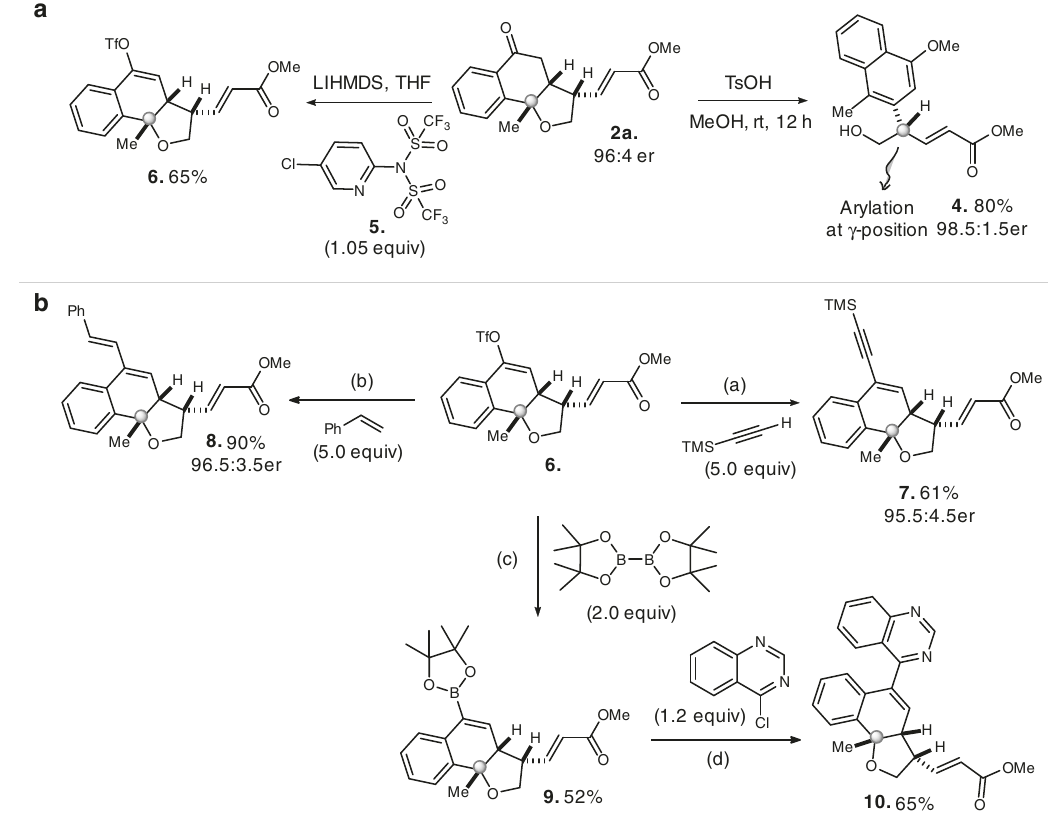
Fig. 7 Transformations of resolution products. Conditions: a with CuI (2.5 mol%), Pd(PPh 3 ) 4 (2.5 mol%), Et 3 N (2.0 equiv) in DMF at room temperature. b with PPh 3 (20 mol%), Pd(OAc) 2 (10 mol%), Et 3 N (2.0 equiv) in THF/CH 3 CN at room temperature. c with PPh 3 (6 mol%), PdCl 2 (PPh 3 ) 2 (3 mol%), K 2 CO 3 (1.5 equiv) in Dioxane at 80 °C. d with Pd(PPh 3 ) 4 (5 mol%), K 2 CO 3 (2.0 equiv) in H 2 O/ Dioxane re fl ux for 24